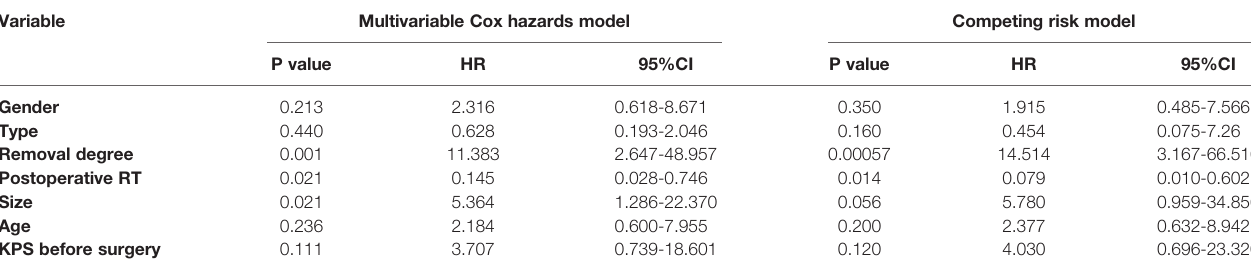
TABLE 3 | Analysis of two models of different treatment modalities.